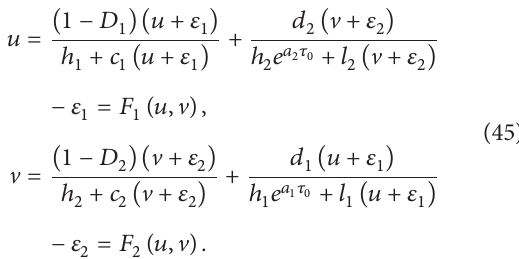
By (13), we get the map 𝐹(𝑢, V ) = (𝐹 1 (𝑢, V ), 𝐹 2 (𝑢, V )) ; that